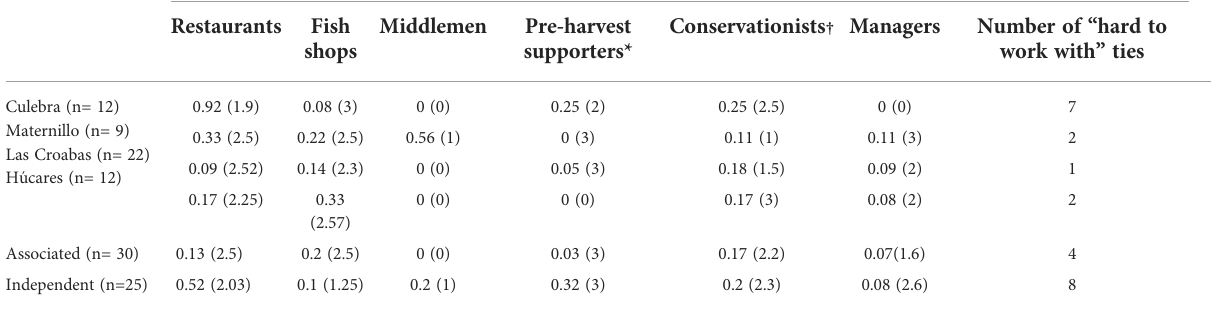
TABLE 6 Summary of the network of support received by fi shers from institutional supporters.